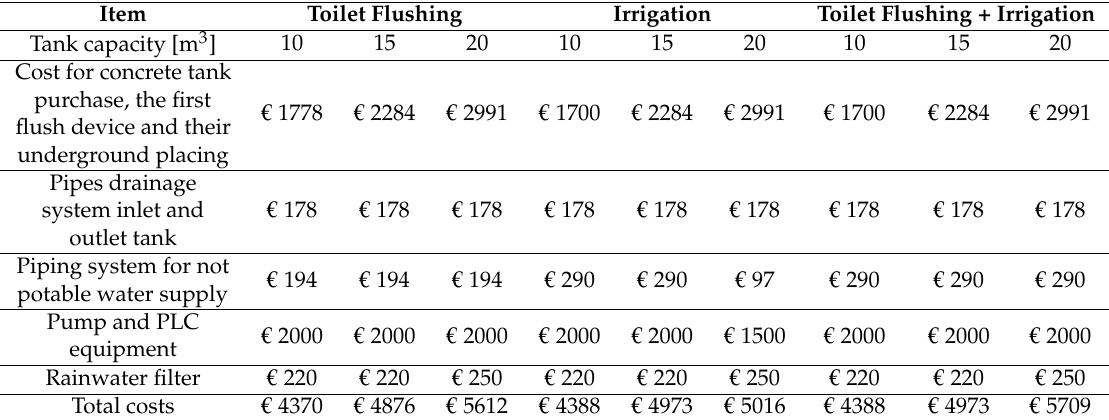
Table 4. Elements costs of a schematic RWH system for each tank size and rainwater